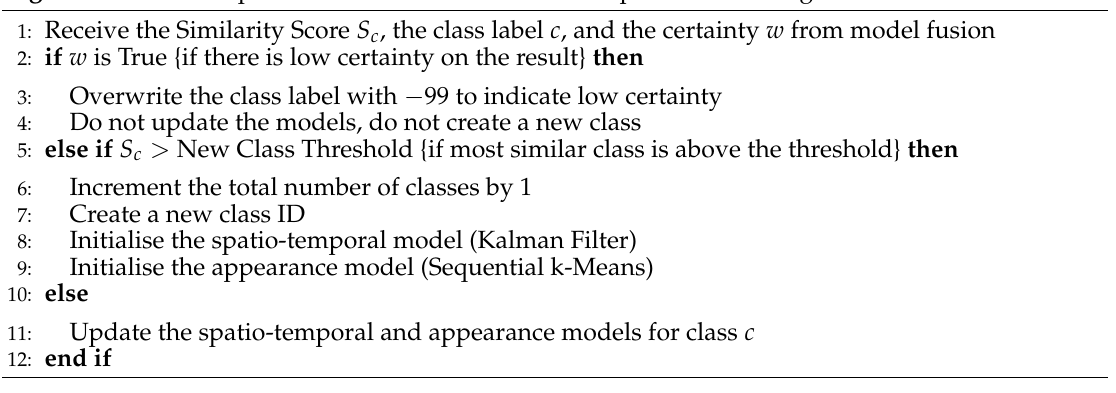
Algorithm 2 Model update and class creation with unsupervised learning.